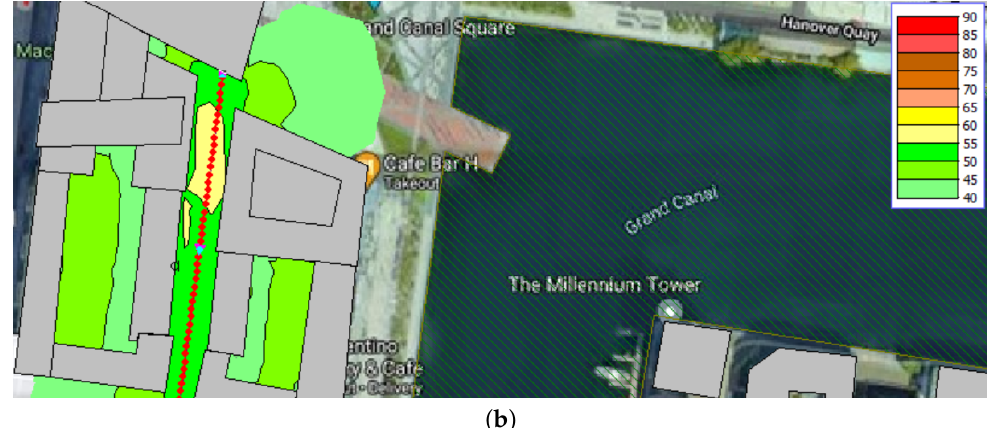
Figure 10. Fly over noise maps ( a ) 5 m ( b ) 30